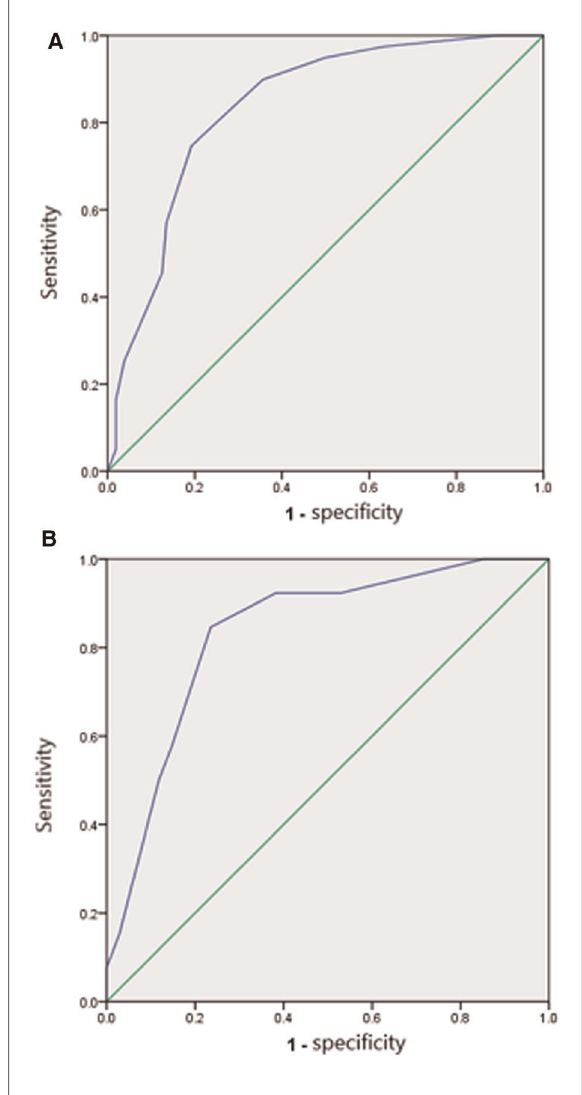
FIGURE 5 ( A ) ROC curve of the model in the training set. The AUC was 0.837 (95% CI: 0.779 – 0.895). ( B ) ROC curve of the model in the validation set. The AUC was 0.835 (95% CI: 0.730 –